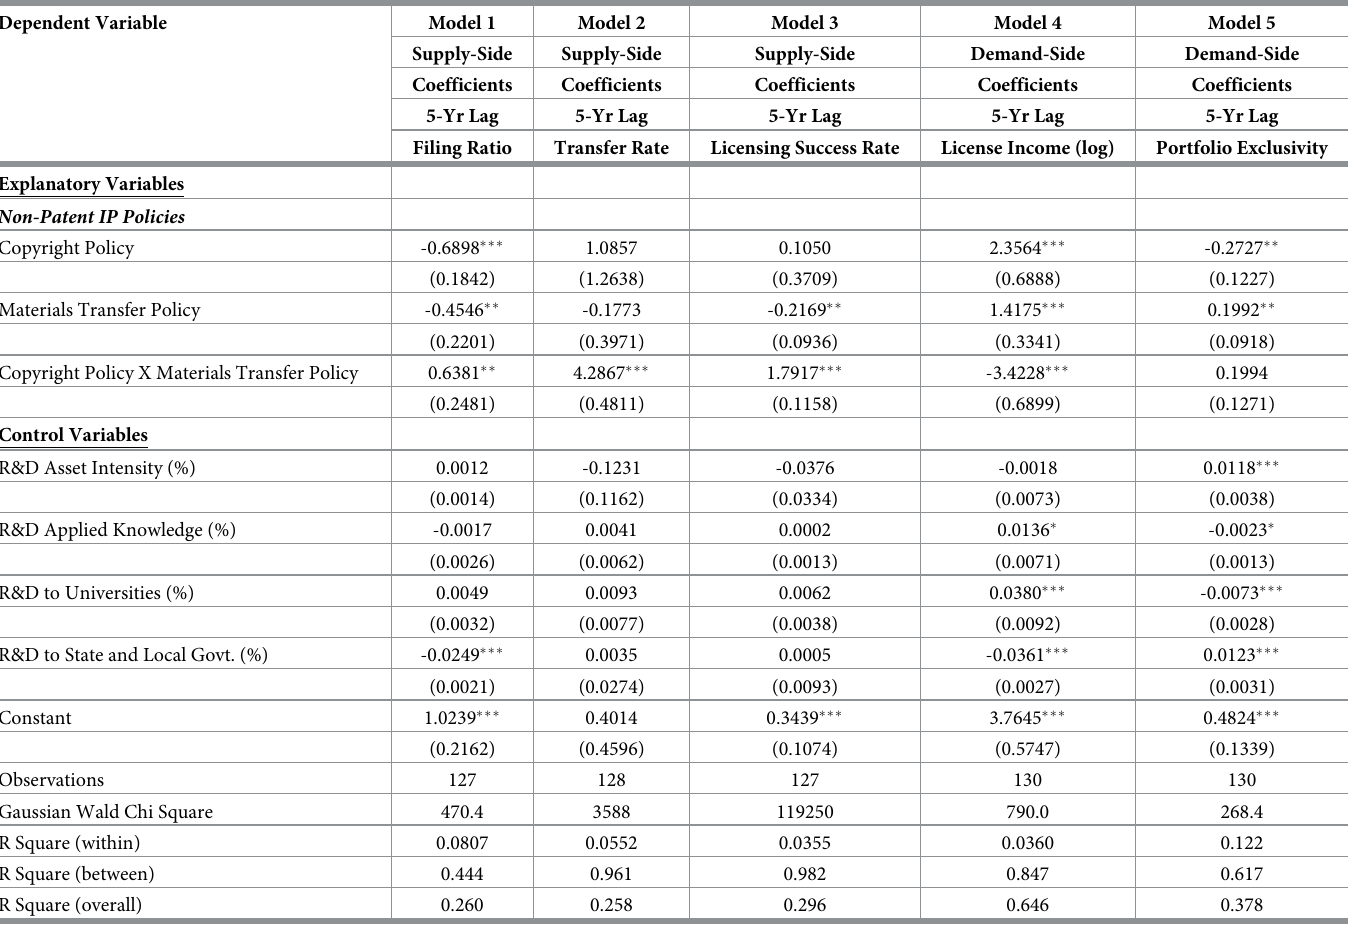
Table 5. The interaction effects of non-patent IP policies on federal agency technology transfer performance